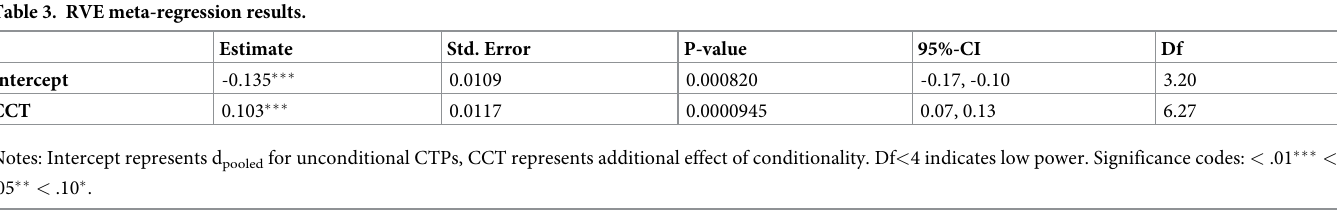
ety at follow-up, however, MLMA revealed very small significant effects, indicating that low power in the RVE-analysis may have prevented the detection of significant results. Estimates for I-squared were lower than RVE-estimates, with small between study heterogeneity for depression/anxiety at both post-intervention (I 2 = 11.49%) and follow-up (I 2 = 0.00%), but considerable heterogeneity for stress (I 2 = 85.74%). In line with these results, tests for heteroge- neity were significant for both depression/anxiety and stress post-intervention, but insignifi- cant for depression/anxiety at follow-up.